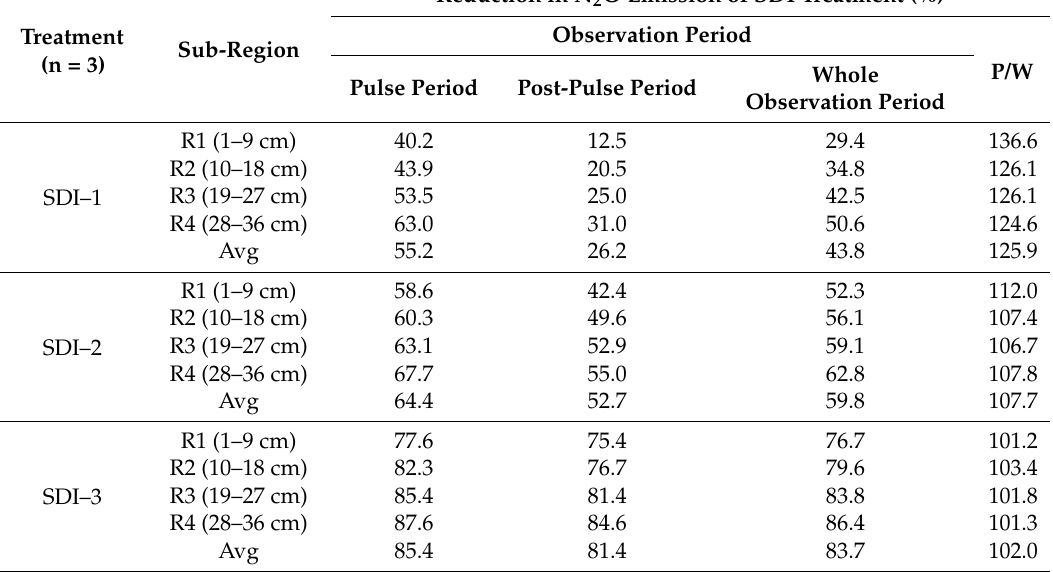
Table 1. Reduction in N 2 O emissions from different sub-regions of SDI treatments at different observation periods.